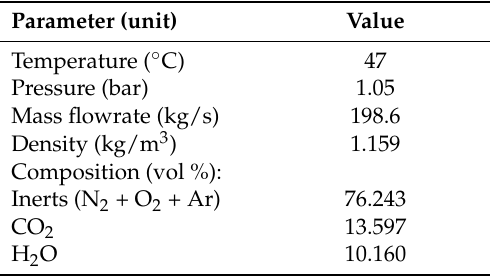
Table 1. Flue gas specifications used in the MBTSA